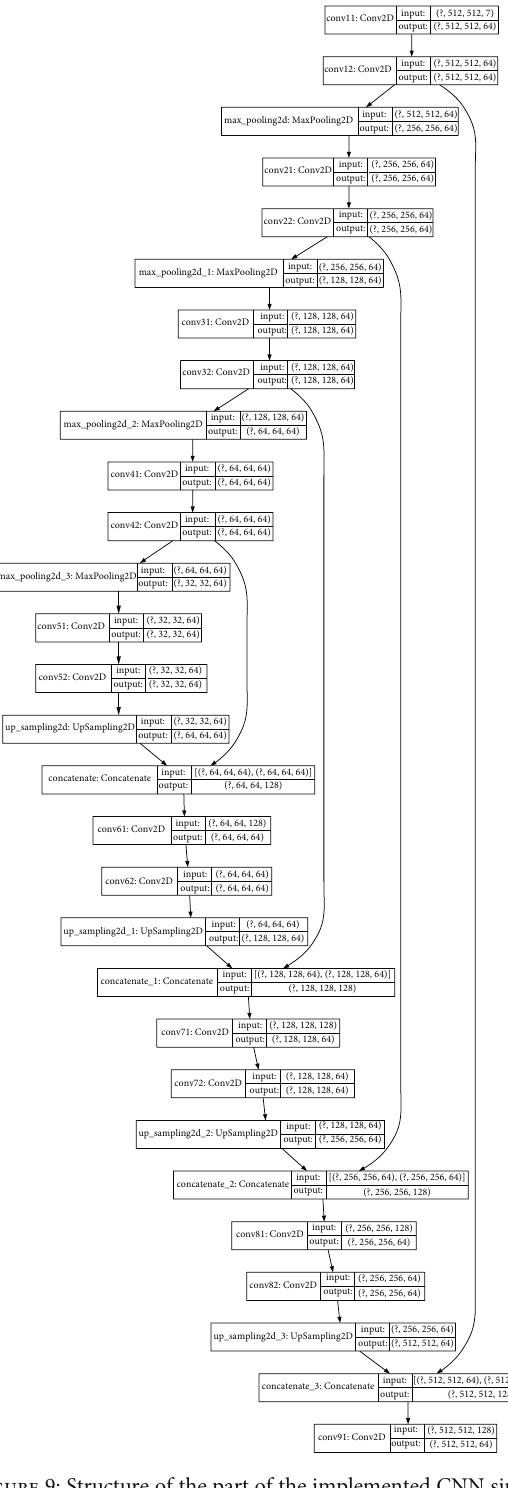
Figure 9: Structure of the part of the implemented CNN similar to the